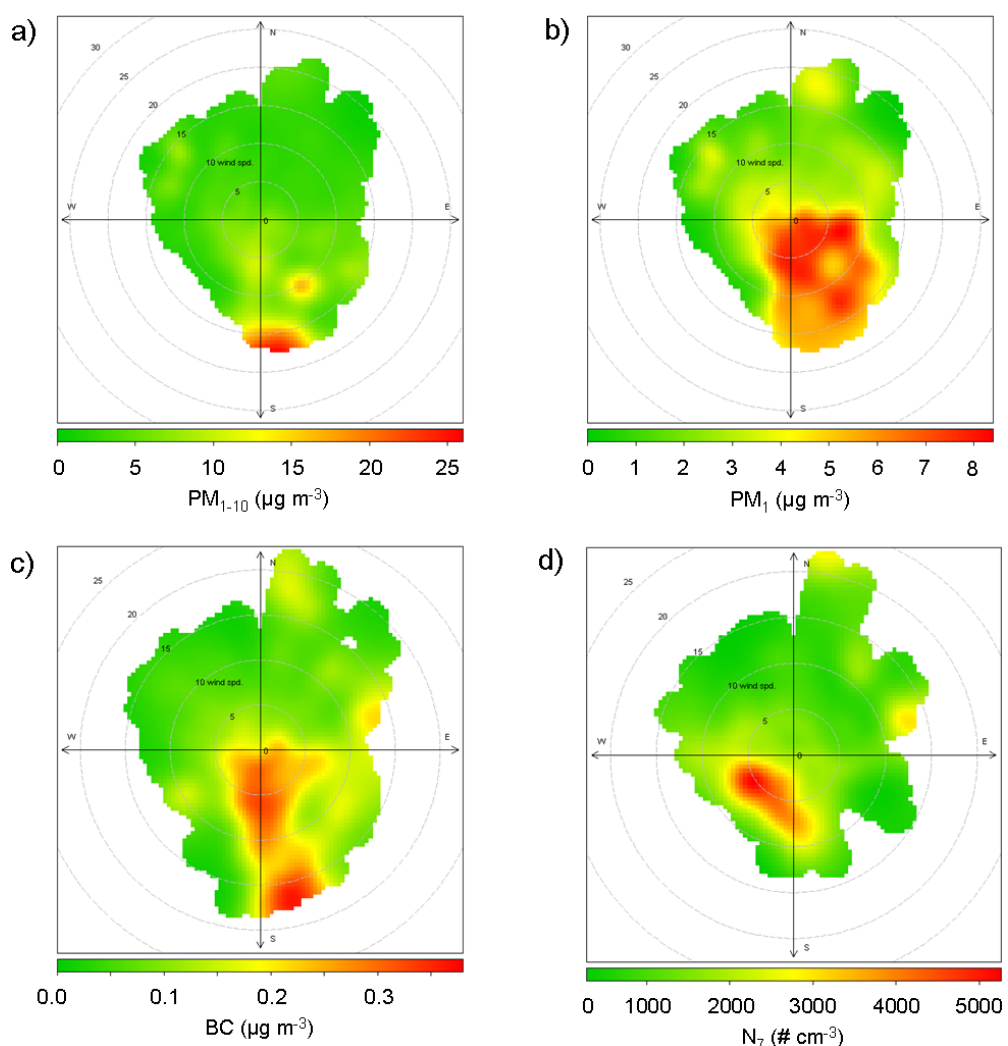
Fig. 5. Hourly concentrations of (a) PM 1 − 10 , (b) PM 1 , (c) BC, (d) N7 during the study period as a function of the wind speed and direction at